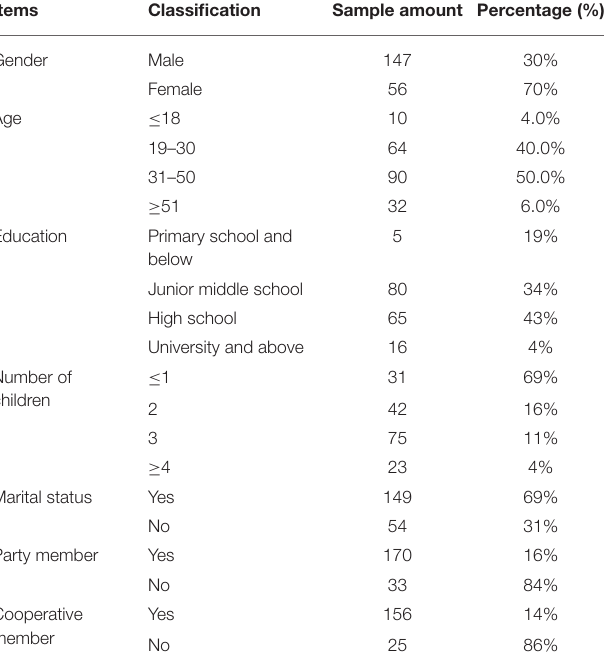
TABLE 1 | Respondent demographics ( N =